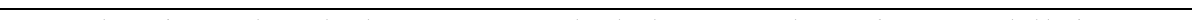
Fig. 1 RAN translation of C9ORF72 hexanucleotide repeats can initiate with and without 5 ′ -cap. a Schematic of monicistronic dual-luciferase reporters for RAN translation and canonical AUG translation. b HeLa Flp-In cells were induced to express translation reporters by doxycycline for 24 h. Relative RAN translation products from Frame-GA and Frame-GP were compared to no-repeat control. NLuc signals were normalized to FLuc in each sample. c Immunoprecipitation using MYC antibody from cells expressing Neg-NLuc or C9R-NLuc, followed by immunoblotting with GA or GP antibody. d Schematic of bicistronic reporters for cap-independent RAN translation and AUG translation. e Relative RAN translation products from Frame-GA and Frame-GP were compared to no-repeat control. NLuc signals were normalized to FLuc in each sample. f Immunoprecipitation using MYC antibody from bicistronic reporter cells followed by immunoblotting with GA or GP antibody. g Schematic timeline of siRNA transfection and induction of luciferase reporters in HeLa Flp-In cells. h Reporter cells were transfected with non-targeting siRNA or siRNA against cap-binding protein eIF4E. Immunoblotting of eIF4E showed the knockdown ef fi ciency. GAPDH was blotted as internal control. i Expression of AUG-FLuc translation (left) and C9R-NLuc RAN translation (right) reporters in presence of eIF4E siRNA compared to non-targeting siRNA control. * P < 0.05, ** P < 0.005, *** P < 10 – 6 , two-tailed t- test. j Reporter cells were treated with mTOR inhibitor Torin 1 for 24 h. Immunoblotting of phospho-4E-BP1 using antibodies recognizing different phosphorylation sites. β -actin was blotted as internal control. k Expression changes of AUG-FLuc and C9R-NLuc in bicistronic reporter cells under mTOR pathway inhibition by Torin 1 treatment. ** P < 0.005, *** P < 0.0005, two-tailed t -test. l The relative translation levels of C9R-NLuc (Frame-GA and Frame-GP) with and without a functional 5 ′ -cap. HeLa cells were transfected with in vitro transcribed monocistronic C9R-NLuc and Neg-NLuc RNA with either 5 ′ -m 7 G cap or ApppG cap analog. The NLuc luciferase was normalized to RNA level in each condition, and each sample was compared with 5 ′ -m 7 G capped C9R-NLuc in frame-GA (set as 100).